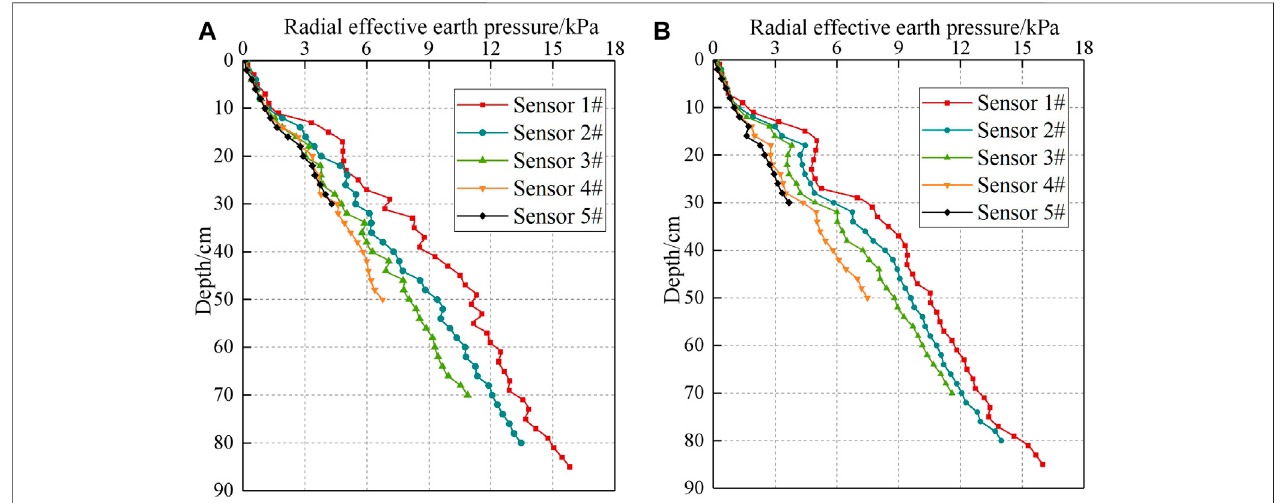
FIGURE 11 | Effective radial earth pressure curves at the pile surface with depth: (A) TP1 and (B) TP2.